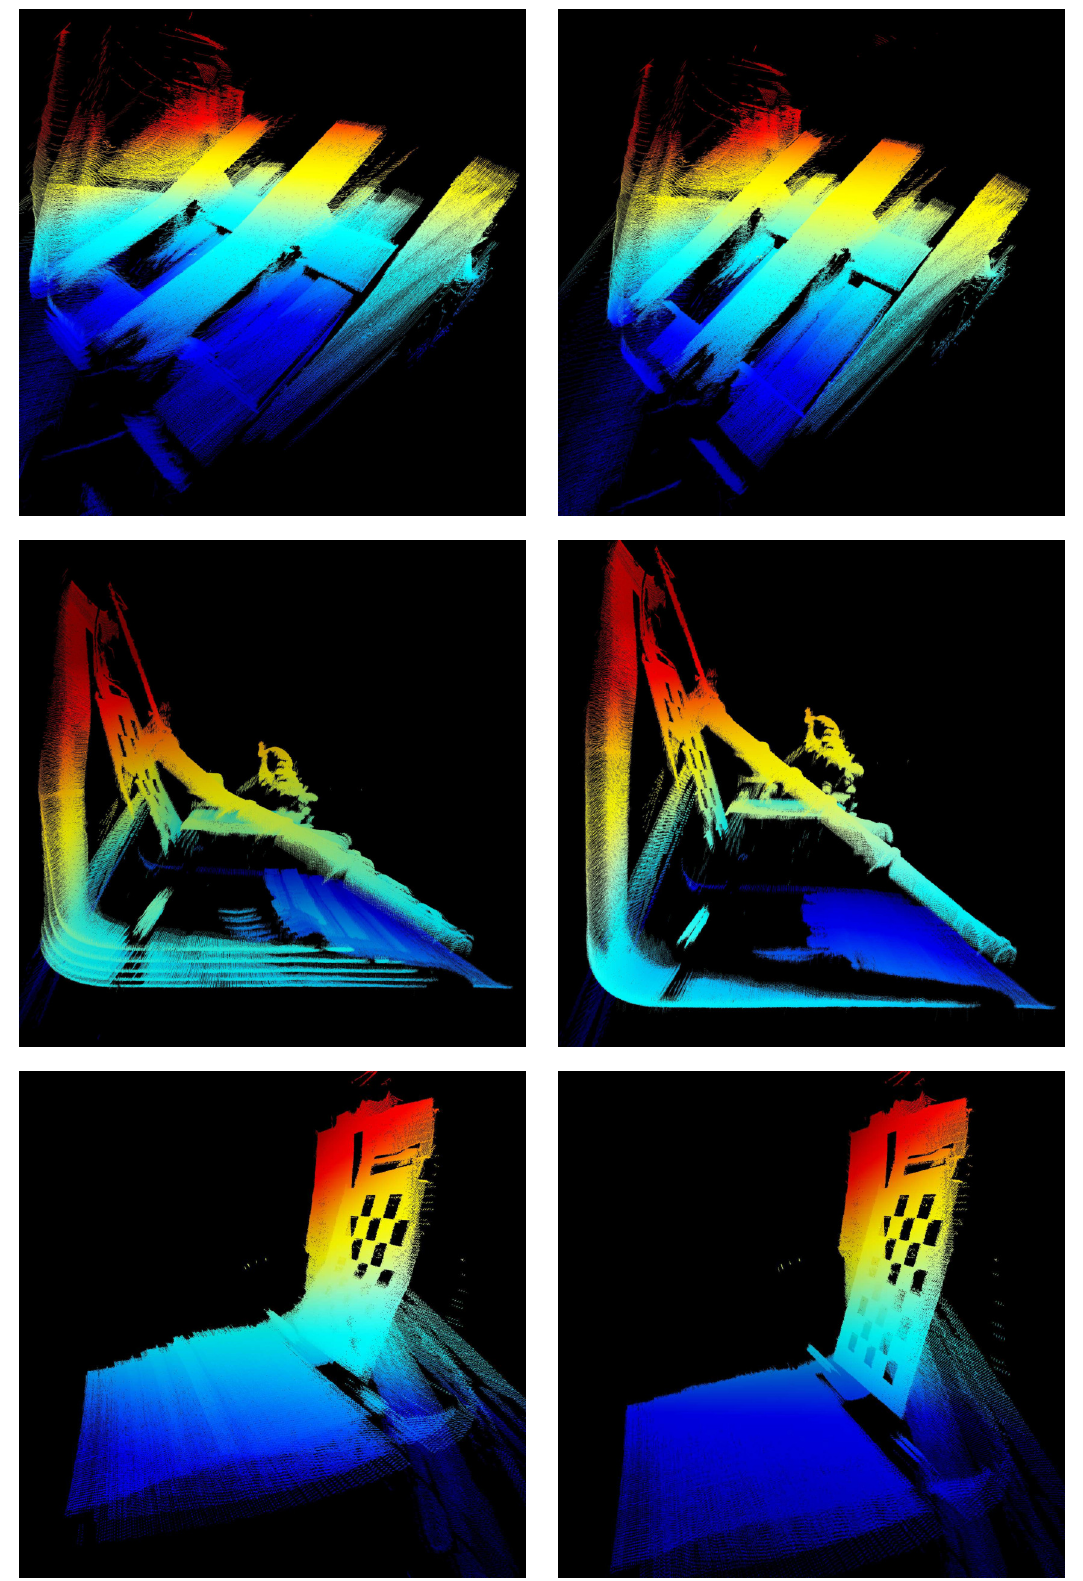
Figure 8. Point clouds of the initial uncorrected reconstruction on the left side and the corrected result on the right side. The point clouds are colored by height. The error as an result of the refraction at the water surface is clearly visible in the uncorrected scans. For example, note that in the middle left scan the point measurements of the floor are not consistent. In the corrected scan, shown in the middle right image, the bottom of the tank is a consistent